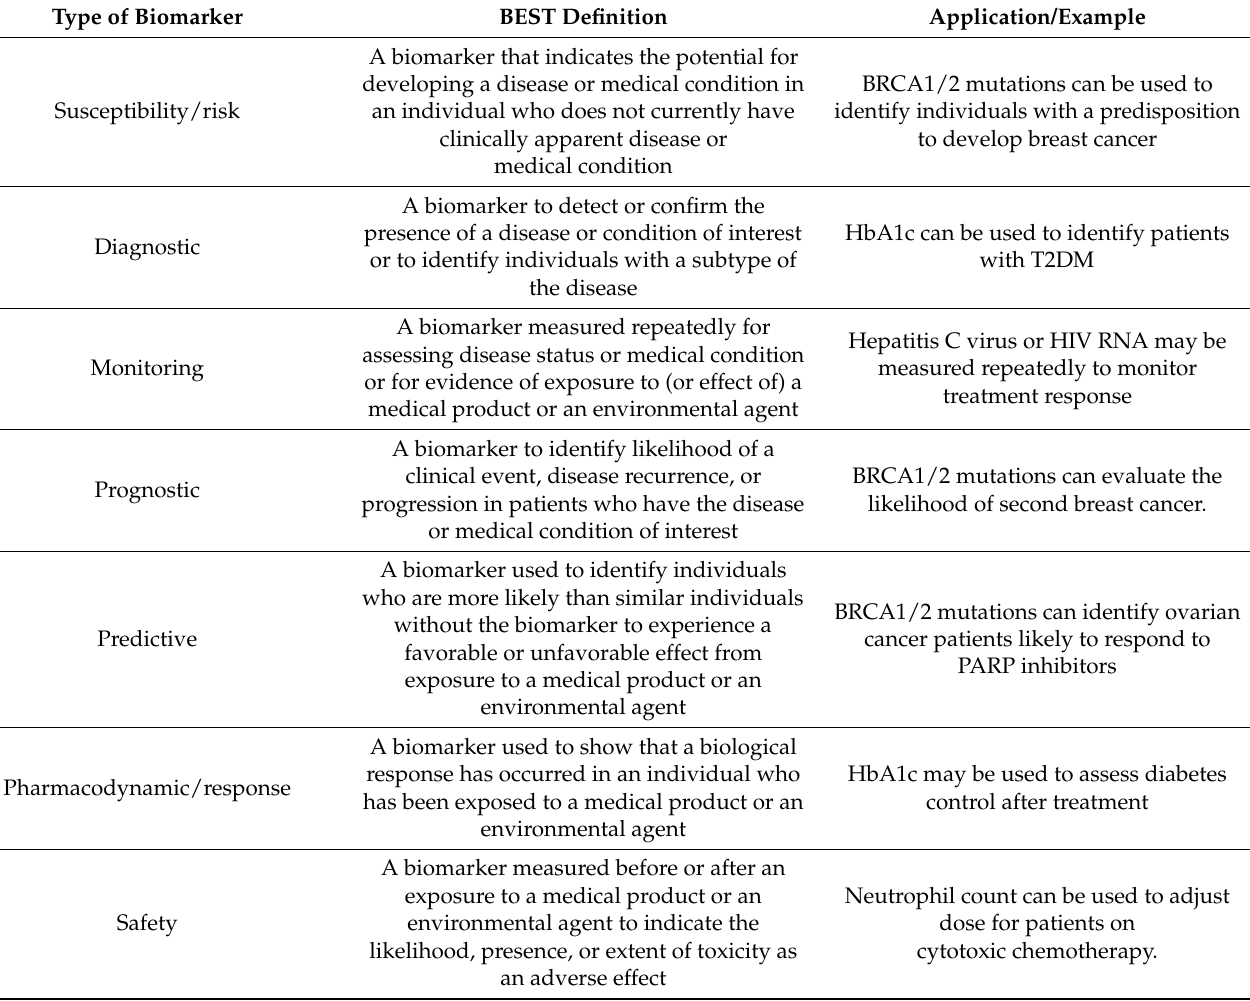
Table 1. Definitions of biomarkers and potential